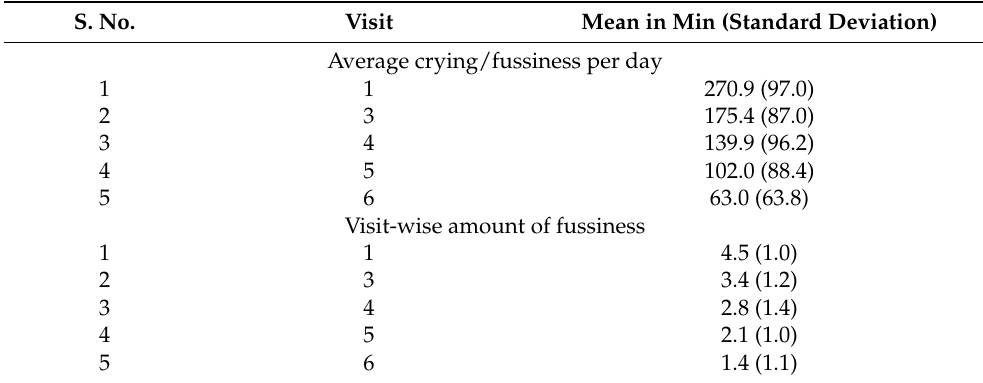
Table 2. Analysis of average crying/fussiness per day and amount of fussiness, n = 112.